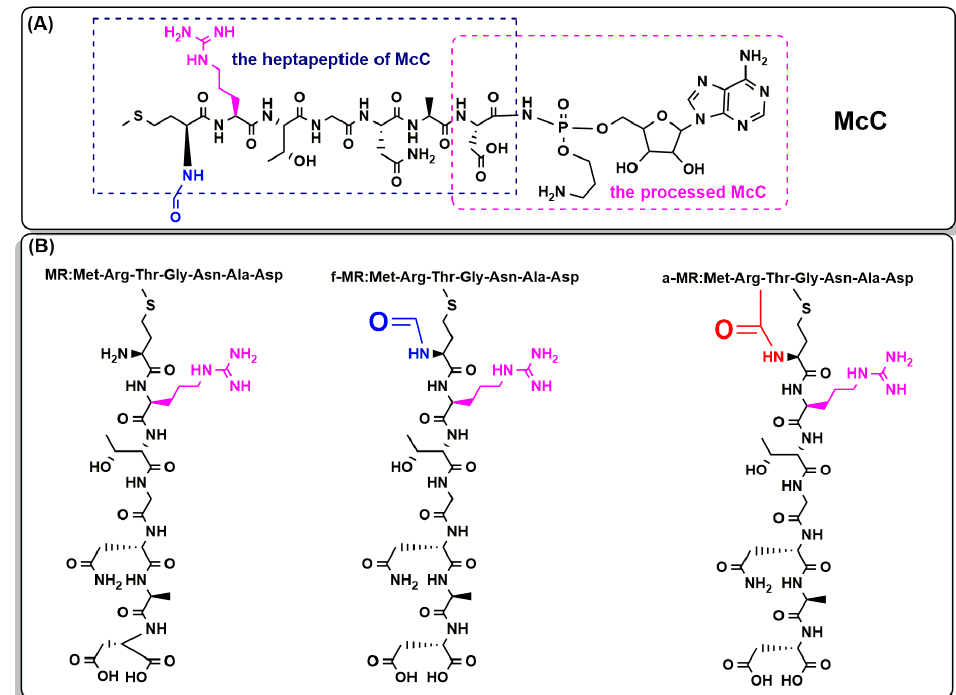
Figure 1. Chemical structures of McC, MR, and its analogues are shown. ( A ) The chemical structure of McC is represented; and ( B ) chemical structures of MR and f-MR, as well as a-MR, are shown.